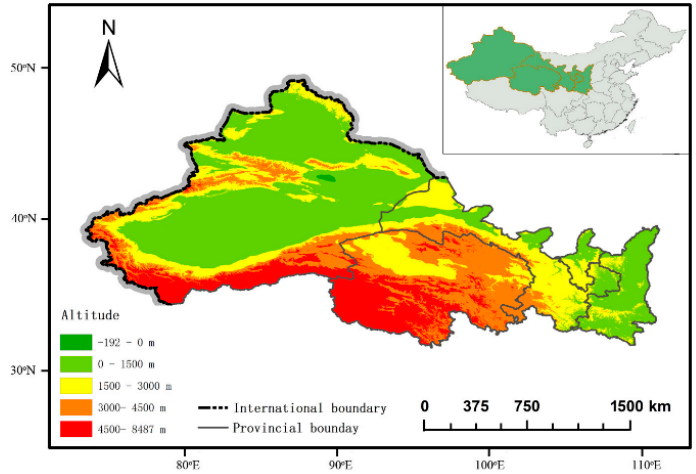
Figure 1. Topographical distribution of Northwest China.